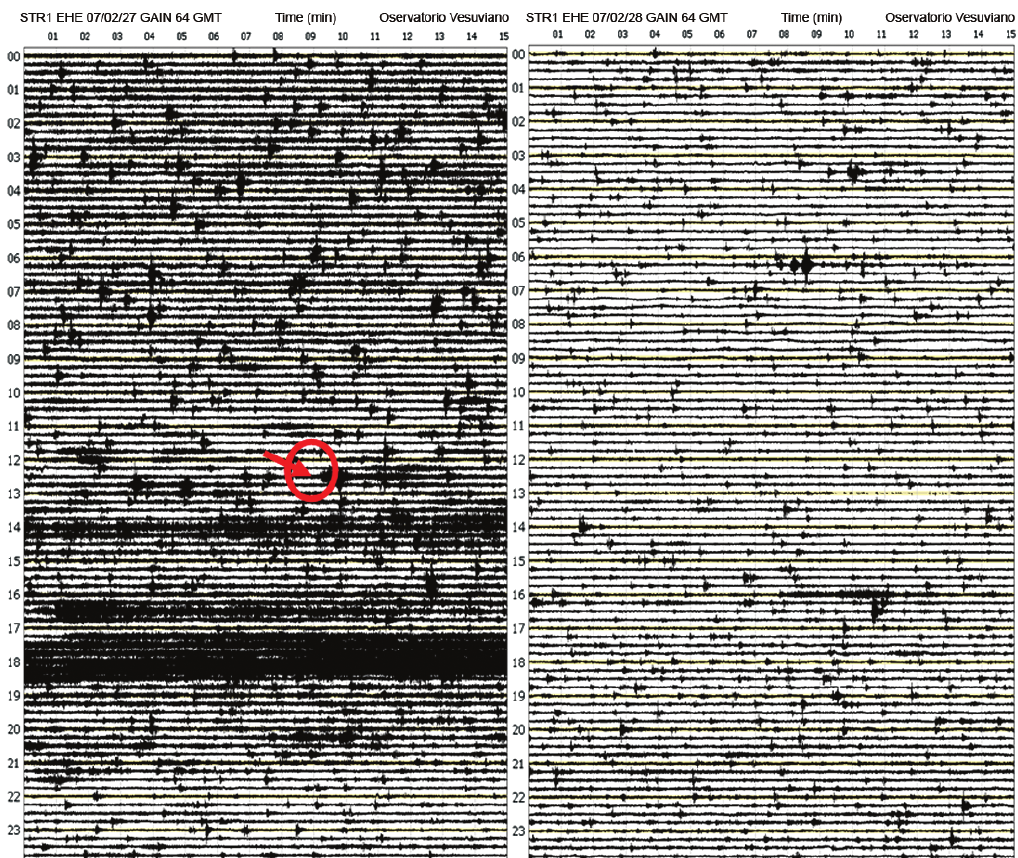
Fig. 11. The seismograms of February 27 and 28, 2007: the red circle indicates the start of the effusive eruption.